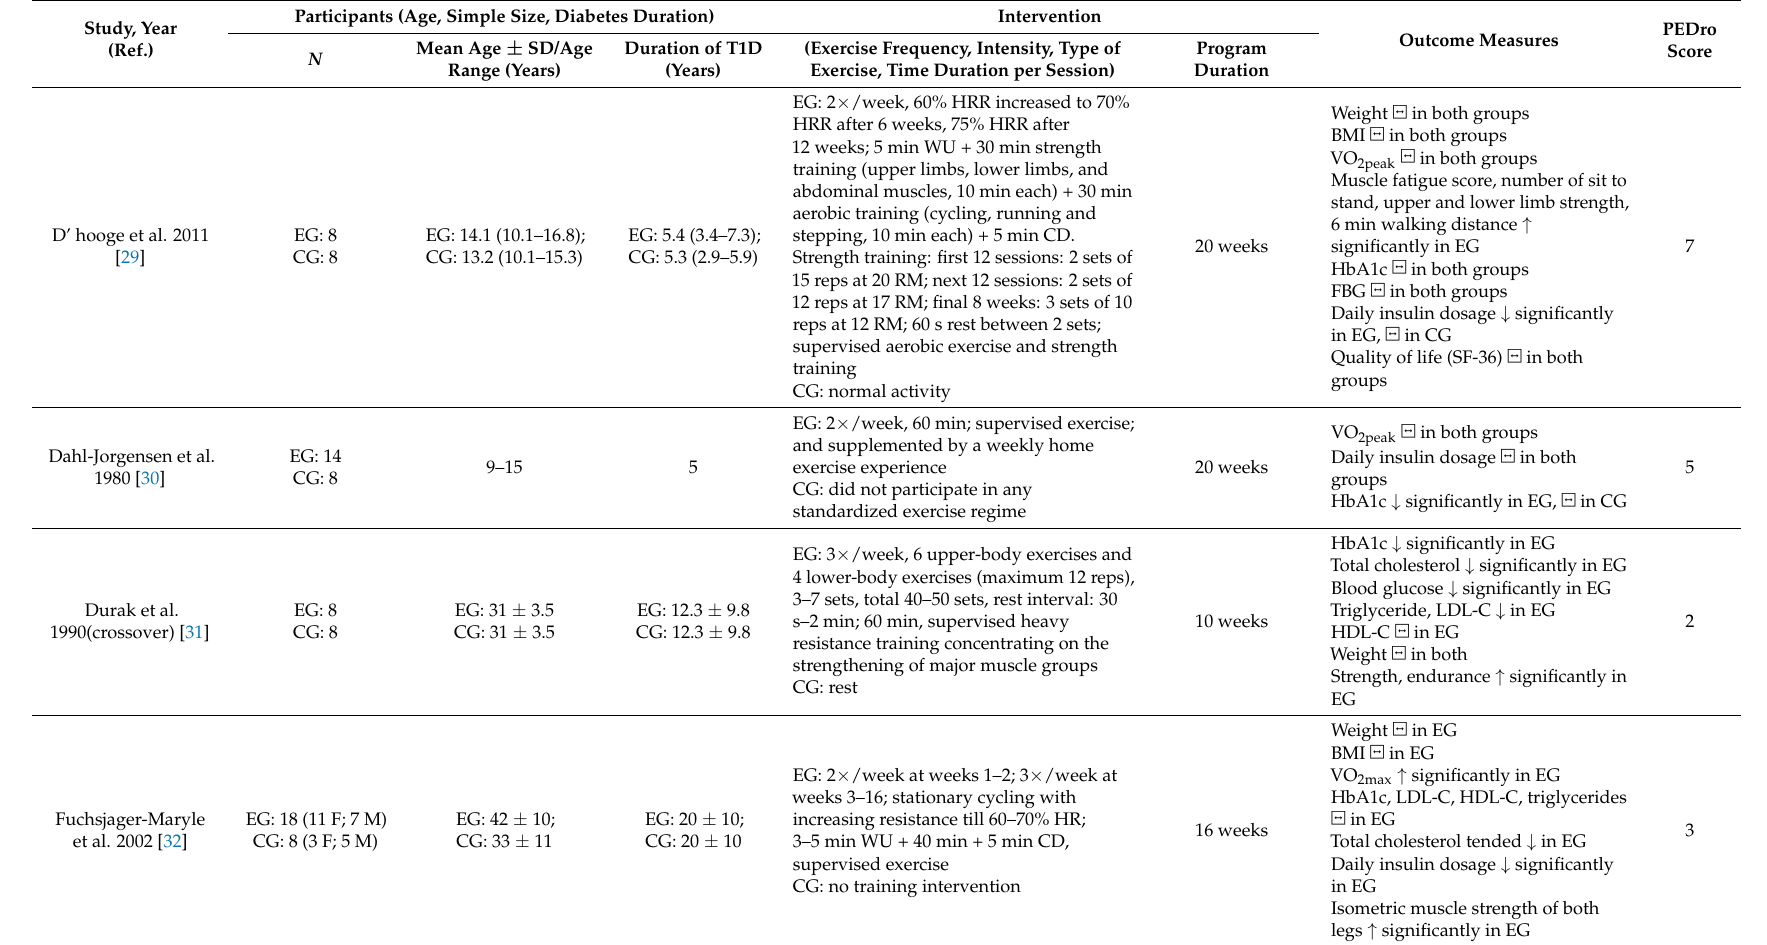
Table 1. Cont. Table 1. Characteristics of the included studies. Table 1. Characteristics of the included studies. Table 1. Characteristics of the included studies.